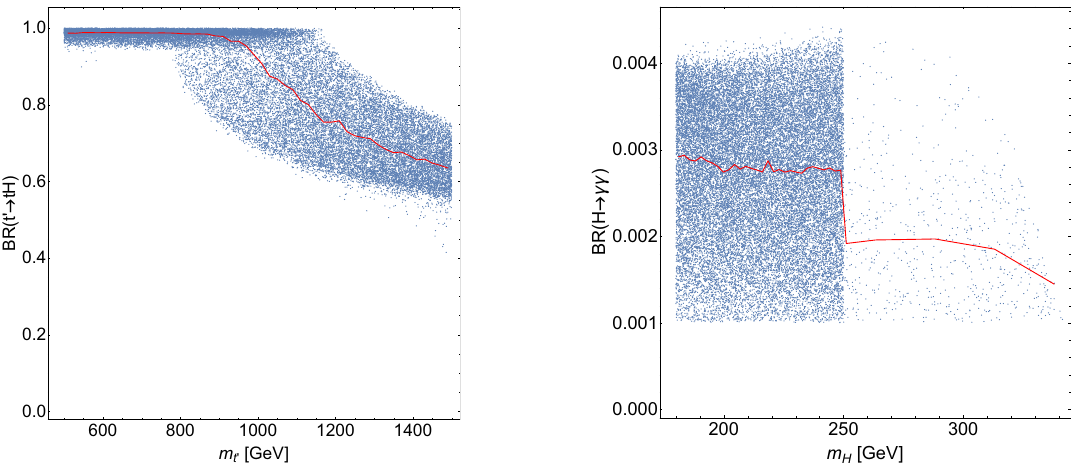
Figure 12 . Scatter plots (in blue) of the BRs of t respective masses and (in red) the median value on the binned samples. The binning for the t 0 BR is 20 GeV while for the H BR it is 2 : 3 GeV for 180 GeV < m H < 250 GeV and 25 GeV for m H > 250